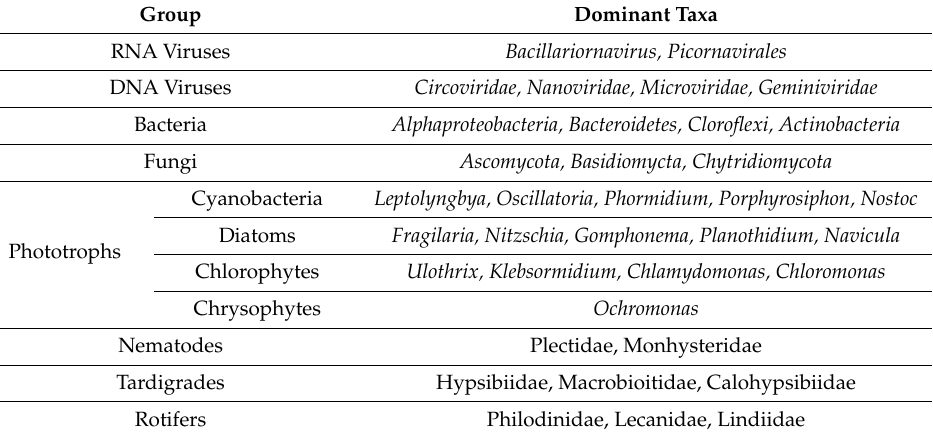
Table 3. ¡ Dominant taxa, per groups, observed in microbial mats from of Peninsula Byers Peninsula. Data compiled from